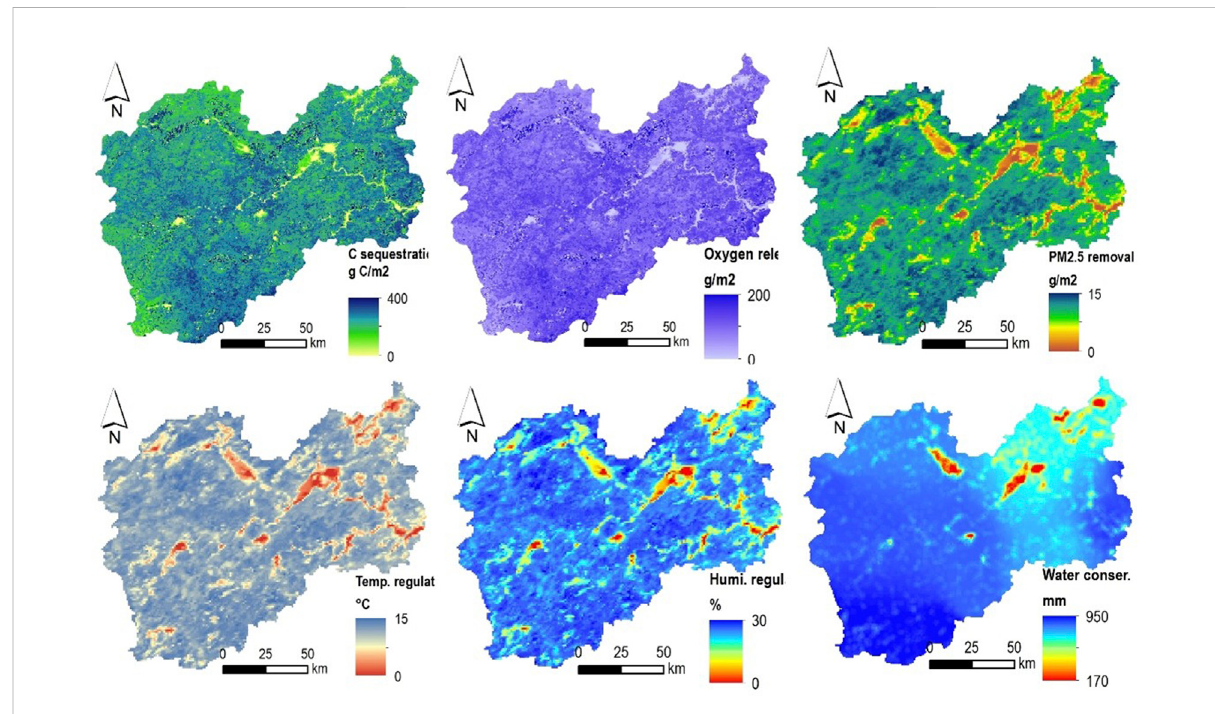
FIGURE 4 Spatial distribution pattern of ecosystem services in Lishui City in 2009.